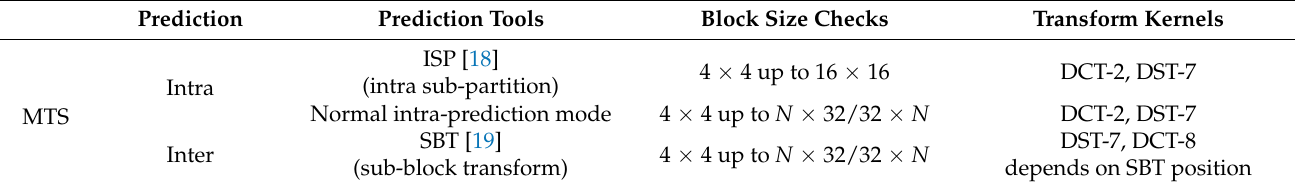
Table 1. MTS transform kernels based on prediction and block sizes in